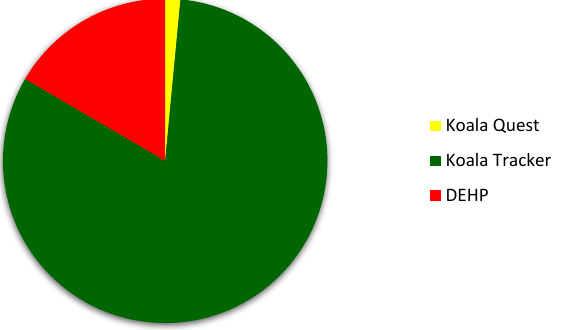
Figure 3. Proportion of sightings produced by each data source—Koala Quest, Koala Tracker, and DEHP.